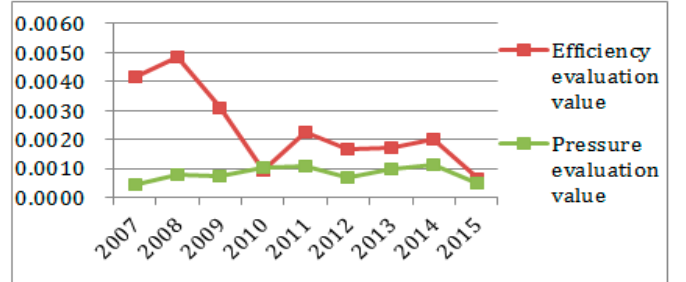
Figure 8. Evaluation value change in the ecological subsystem.